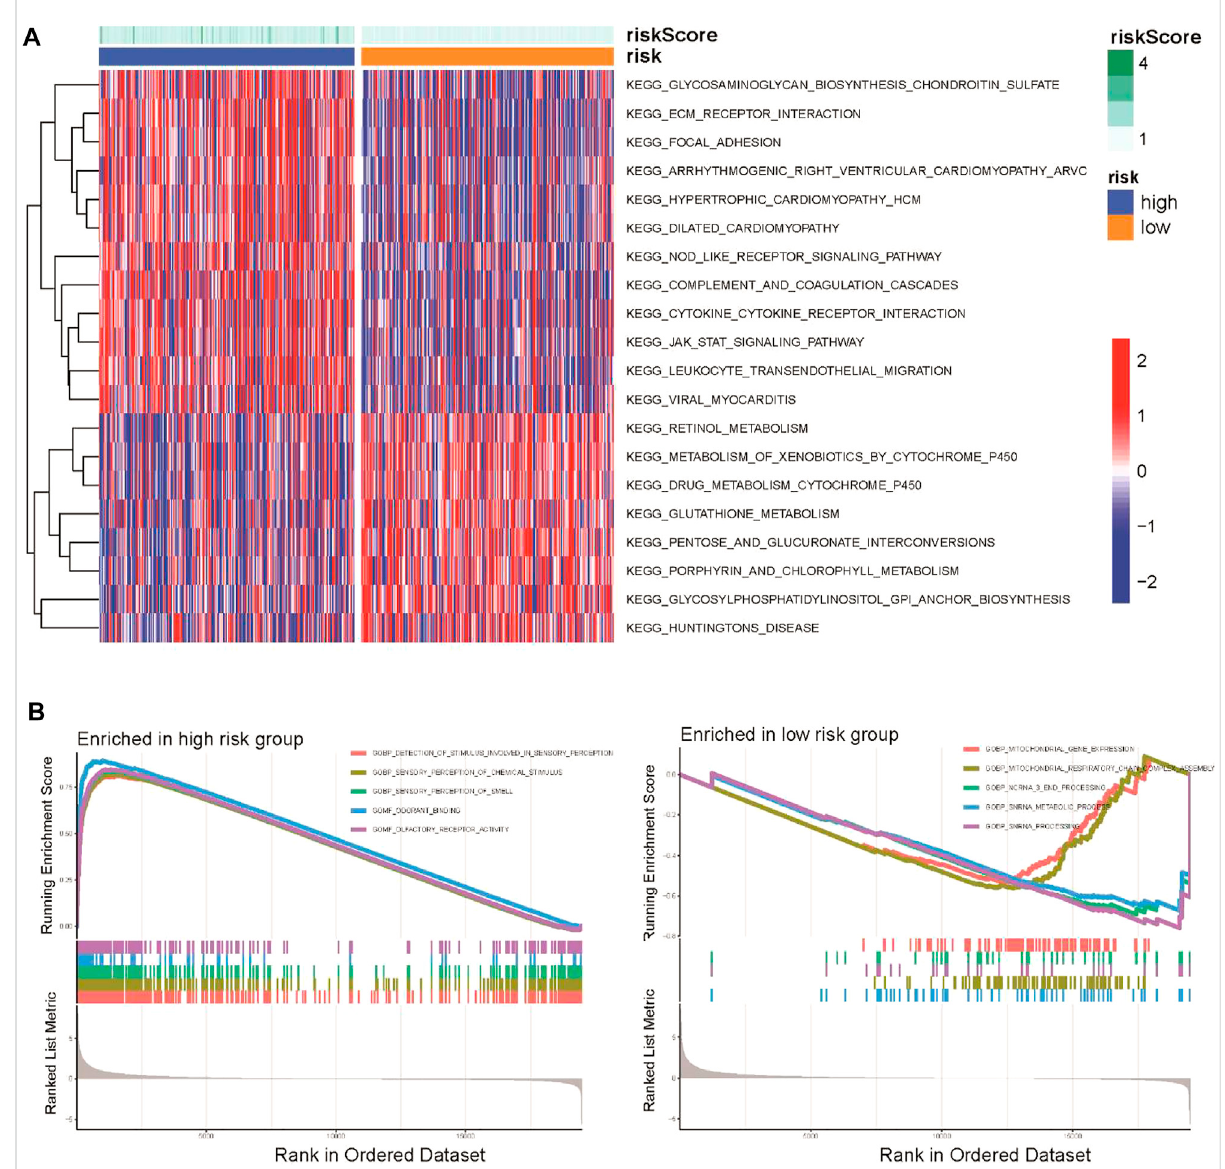
FIGURE 5 Functional and biological pathway analysis of the CSRG prognostic signature. (A) Visualization of pathway enrichment analysis by GSVA between the high-risk and low-risk groups. (B) GSEA of biological pathways between the high-risk and low-risk